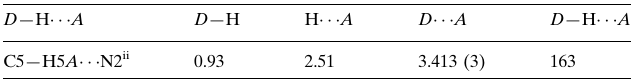
Hydrogen-bond geometry (A˚ , (cid:1)